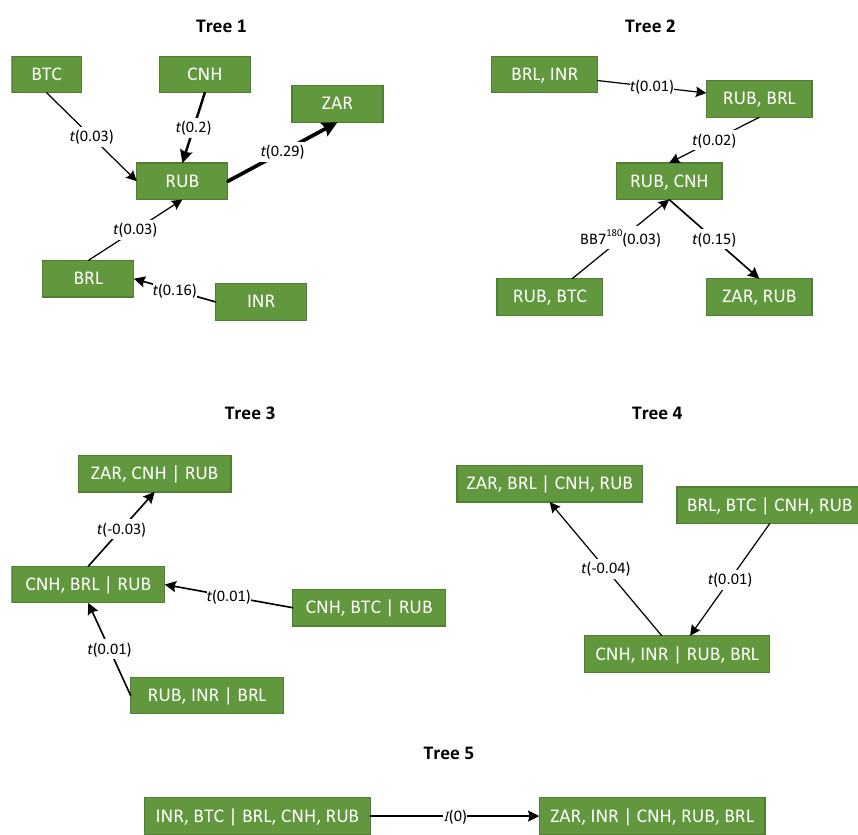
Fig. 5 Estimated R-vine decomposition for BRICS basket. The direction of the dependence transmission path is characterized by an arrow that indicates the pair copula and Kendall’s τ in parentheses. The strength of the dependence is illustrated by the thickness of the arrow